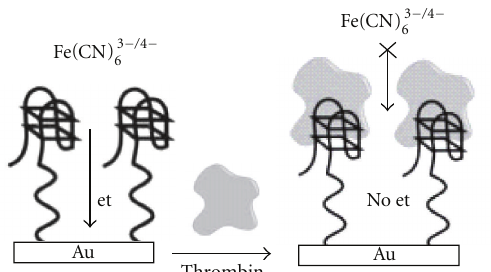
Figure 3: Impedimetric aptasensor: the binding of a target to the aptamer reduces the electron transfer (et) of a small redox mediator di ff using to the electrode surface and the increase the interfacial resistance, which provides a means of measuring the concentration of bound target via impedance spectroscopy.